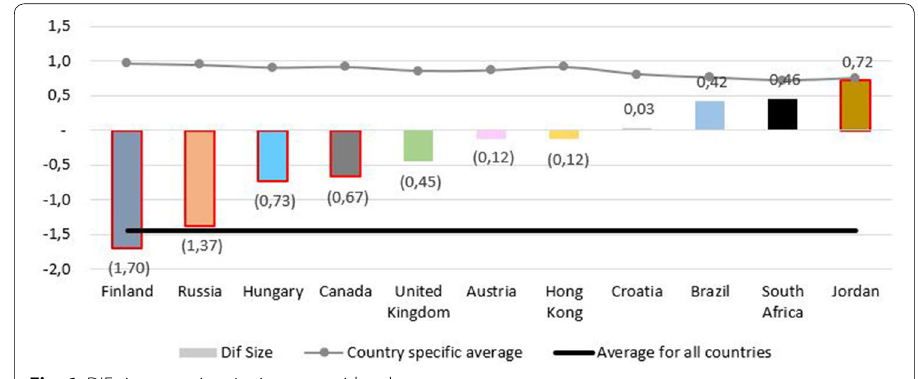
Fig. 6 DIF size: question 4—interest paid on loan